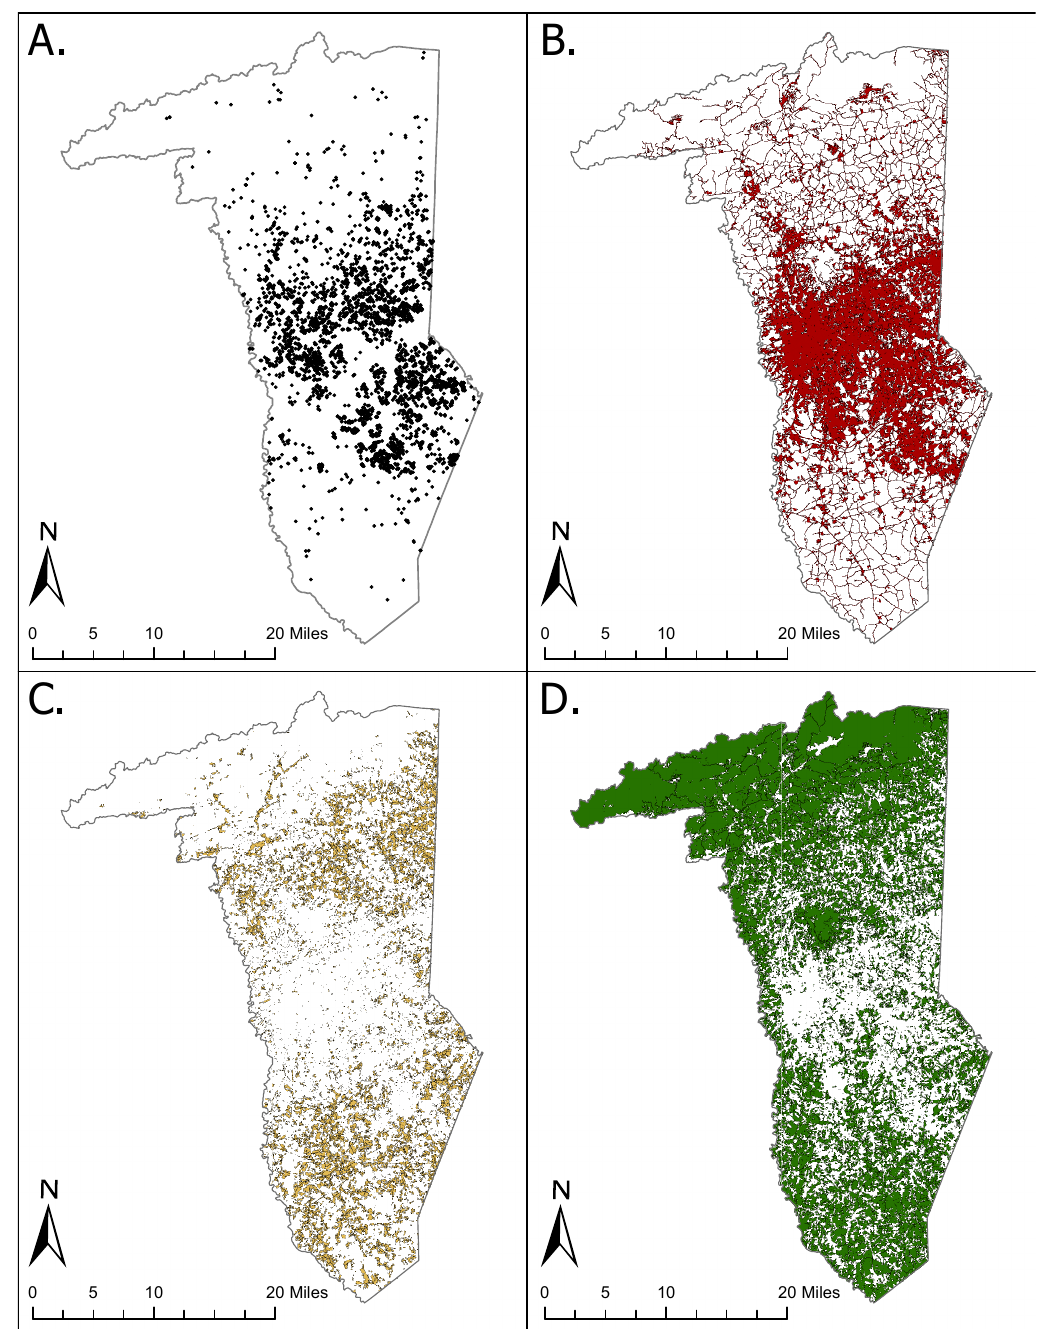
Figure 2. Greenville County, SC 2011 Homes Sales ( A ), Urban/Developed Land Cover ( B ), Pasture Land Cover ( C ), and Forest Land Cover ( D ).